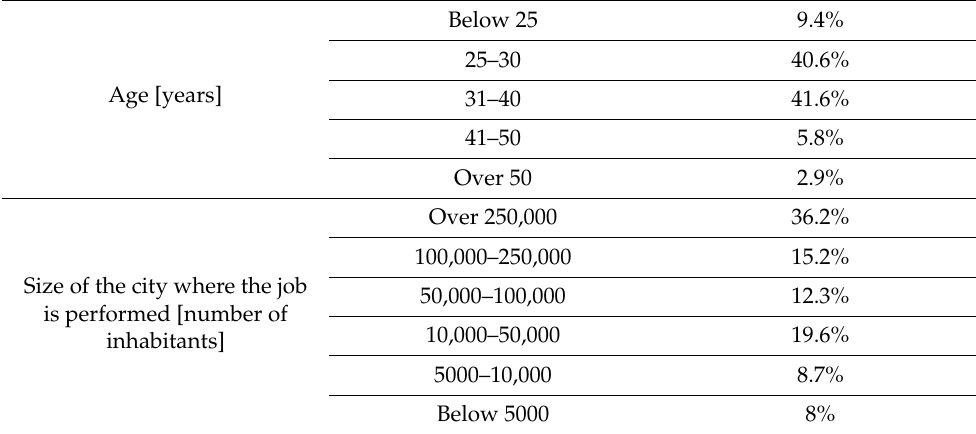
Table 3. Demographic Characteristic of